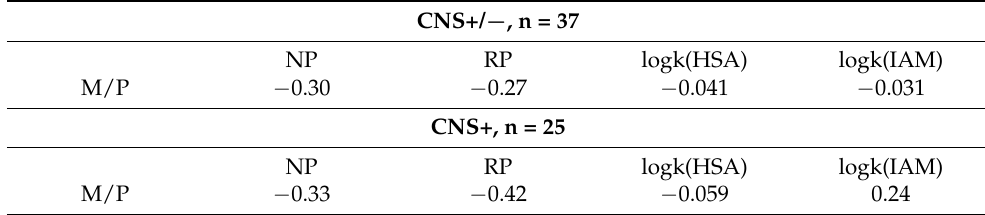
Table 5. Internal correlations between chromatographic parameters for CNS+/ − cases and CNS+ only.